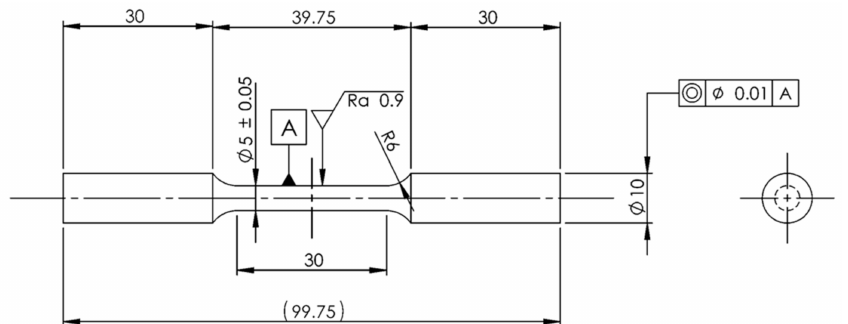
Figure 4. Geometry of plain cylindrical specimens tested under static tensile loading (dimensions are in mm). Specimens have been taken from the axle (see Figure 1 and region 2 of Figure 2), and after that, the cylindrical surface has been machined (Ra = 0.9 µ